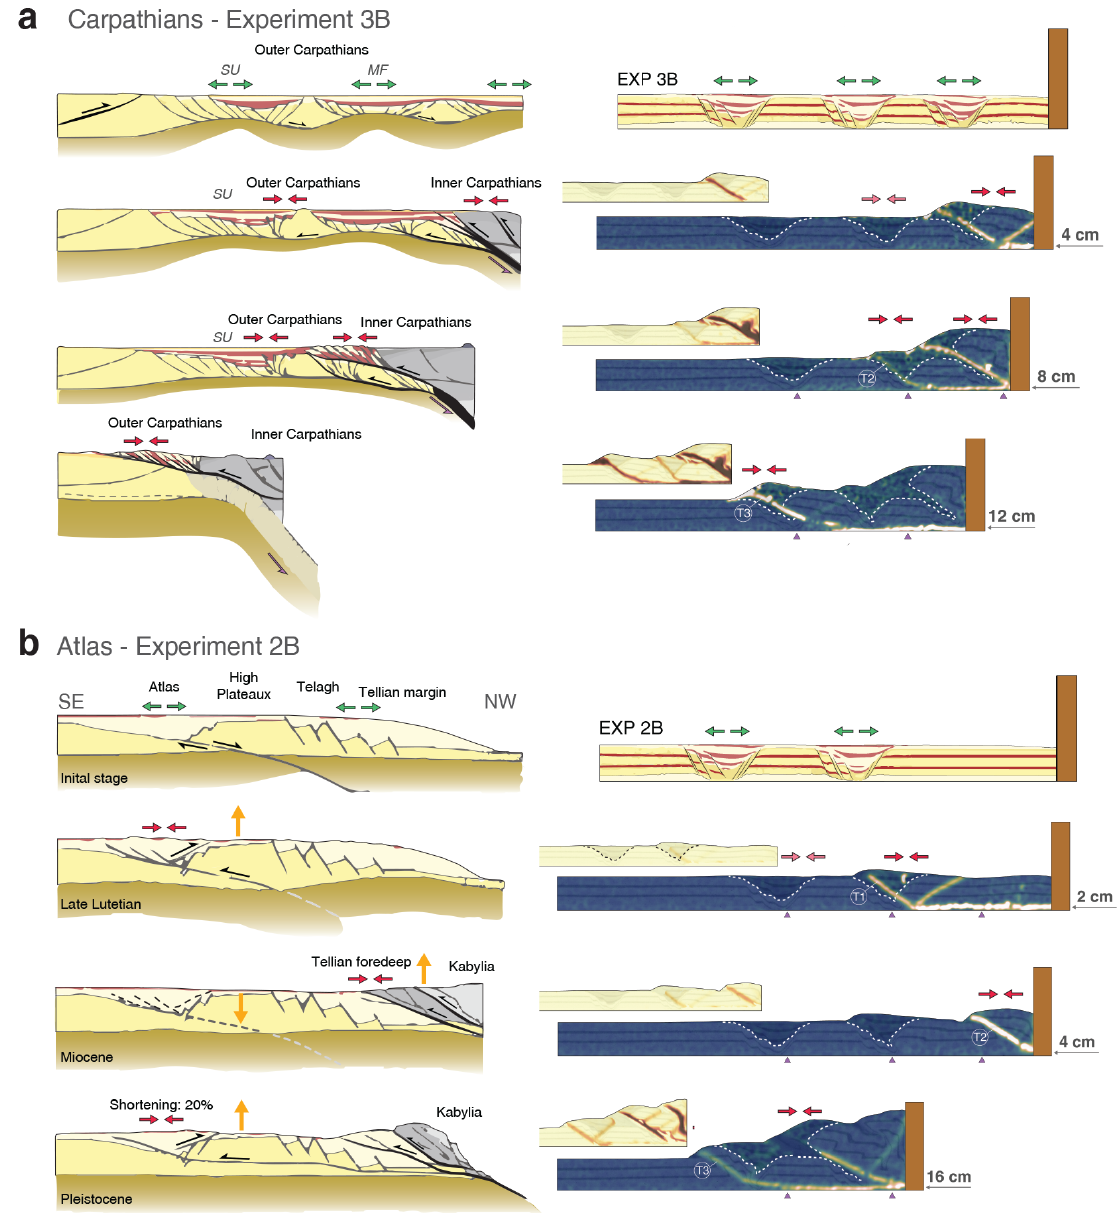
Figure 12. Temporal evolution comparison between selected natural examples and our analogue modelling results. (a) Carpathians vs. EXP3B (redrawn from Picha et al., 2006). MF: Magura Flysch; SU: Silesian Unit. (b) Atlas vs. EXP2B (redrawn from Bracène and de Lamotte,